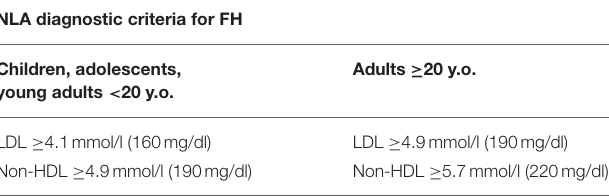
TABLE 5 | National Lipid Association (NLA) diagnostic criteria for familial hypercholesterolemia. NLA diagnostic criteria for FH Children, adolescents, young adults < 20 y.o.